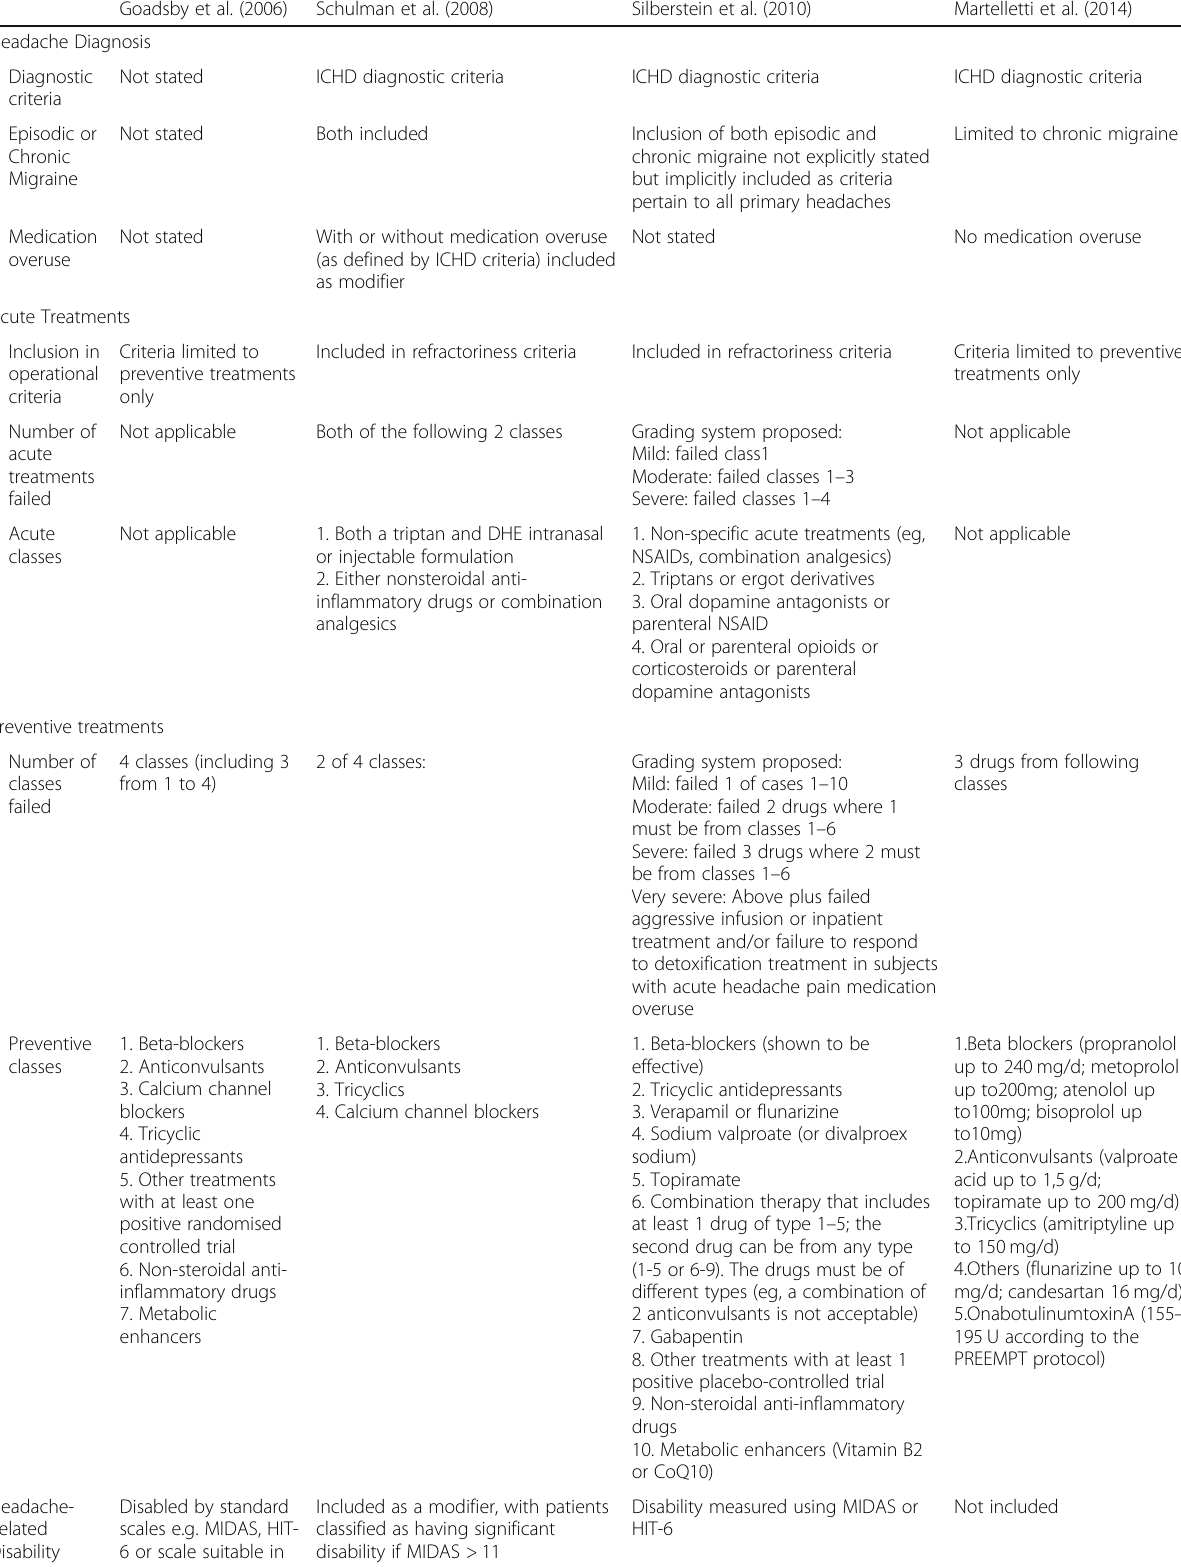
Table 1 Overview of the published proposal for refractory or intractable